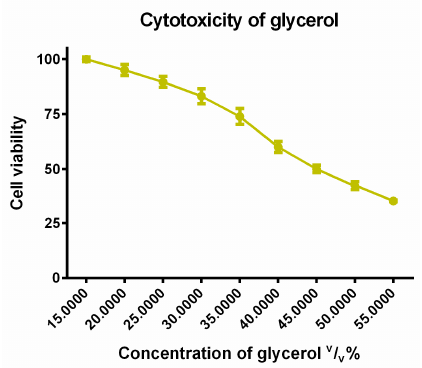
Figure 5. Cytotoxicity of glycerol measured by MTT-assay. Cell viability expressed as the percentage of the absorbance of the untreated control cells. Data expressed as mean ± SEM, n = 12. Cell viability of the samples at the different concentrations: 100% ± 1.1%; 95% ± 2.5%; 90% ± 2.5%; 83% ± 3.4%; 74% ± 3.6%; 60% ± 2.5%; 50% ± 1.7%; 42% ± 2%; 35% ± 0.4%.